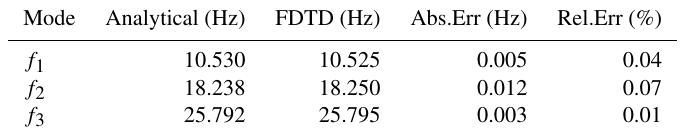
Table 1. Comparison of resonance frequencies obtained analytically and numerically for a lossless spherical waveguide.